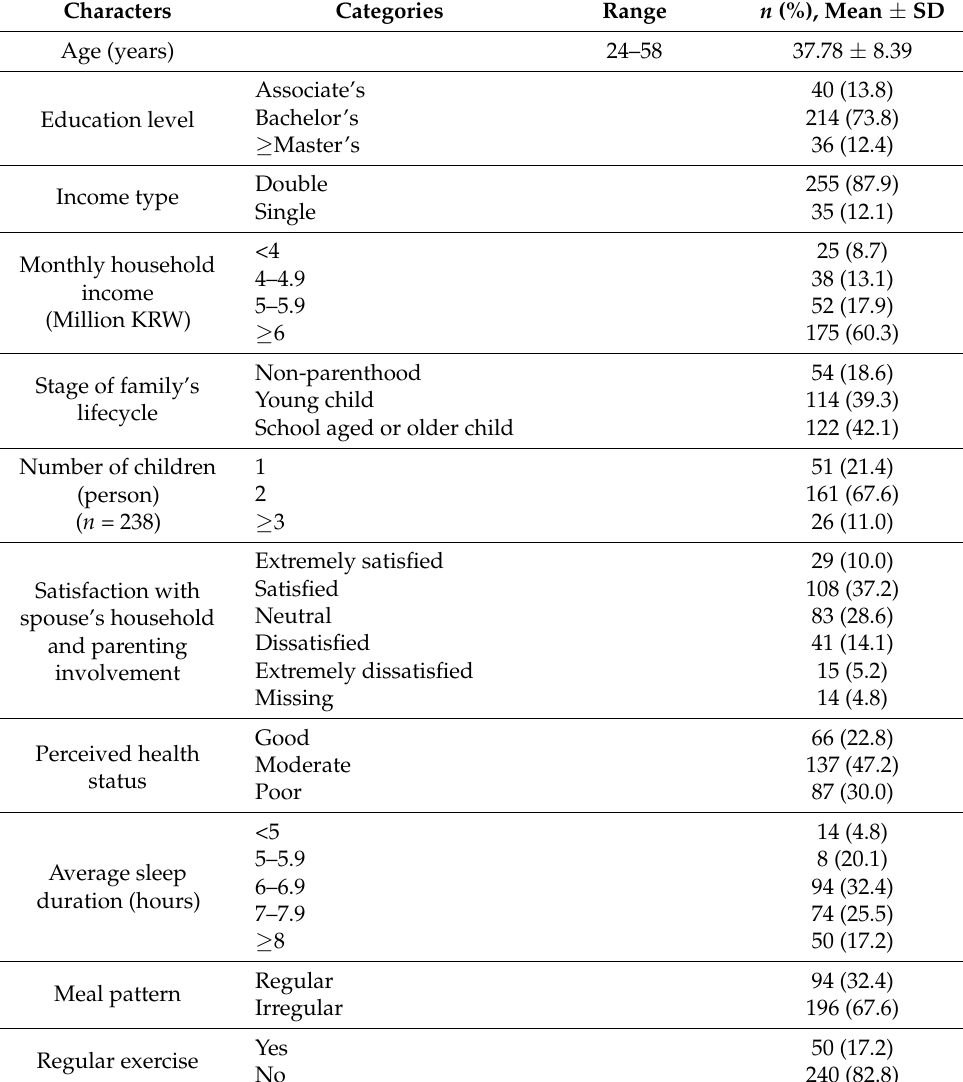
Table 1. Participants’ general characteristics ( n =